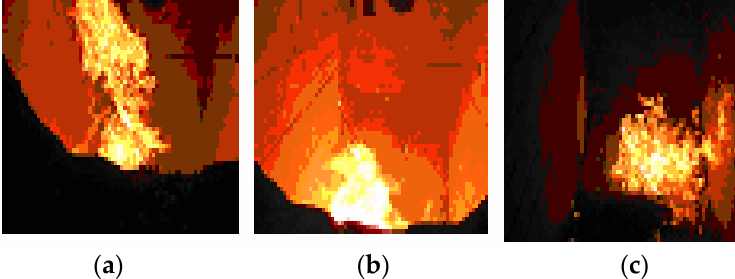
Figure 16. Flame shape: ( a ) obtained flame by burning chopped wood; ( b ) obtained flame by burning string vine; ( c ) obtained flame by burning corn cobs.